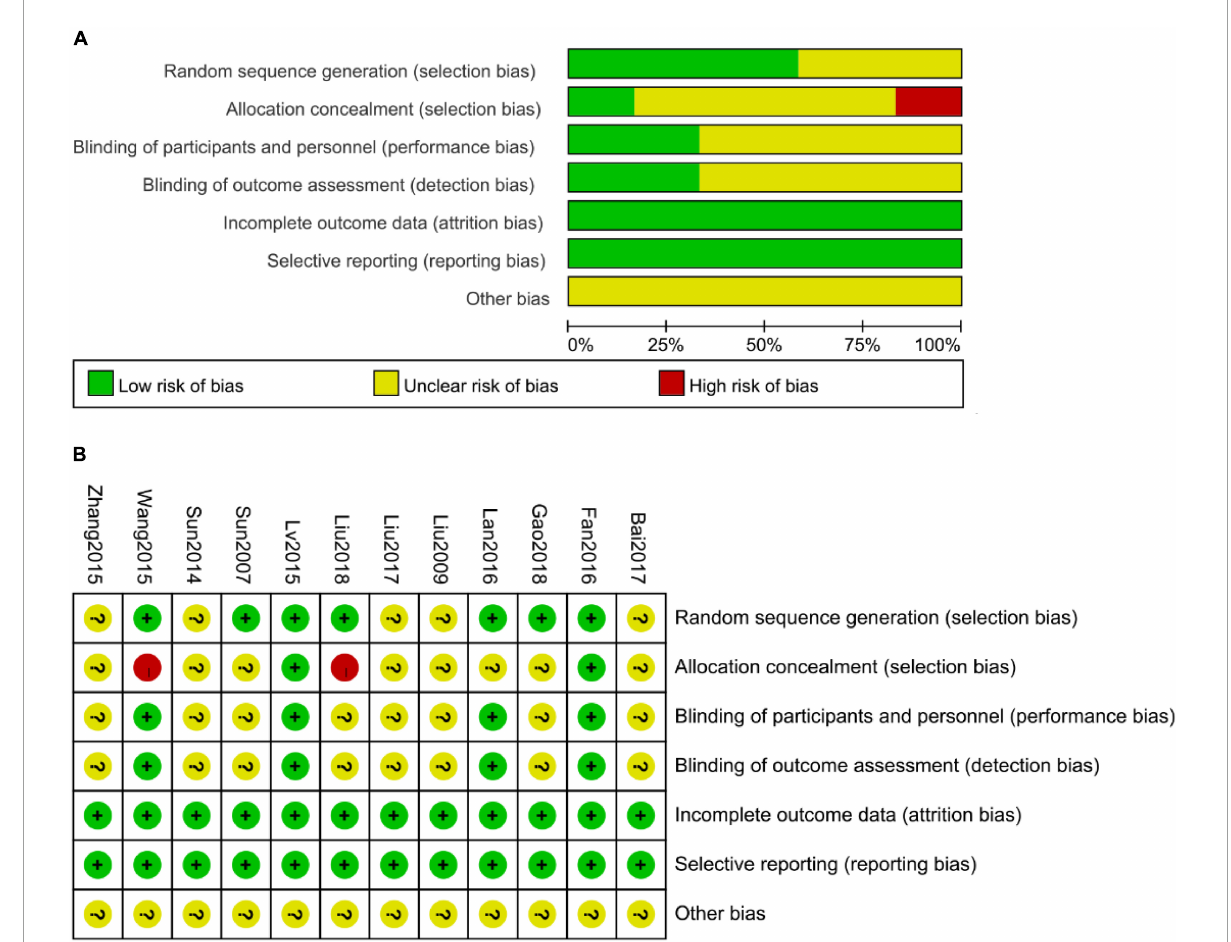
FIGURE2 The risk of bias assessment with the Cochrane Collaboration tool. (A) Risk of bias graph. (B) Risk of bias summary.